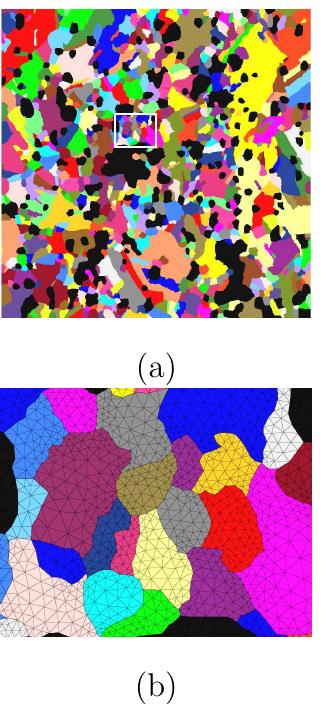
Fig. 10: (a) Dimensions of micro as well as macro structures and Fig. 9: Image (exported Figure 9. Image (exported from software Hypermesh) with “perfect” pixels from Figure 8b; ( b ) a meshing the transition zone in the two-scale simultaneous FE simulation; (b) cut-out corresponding to the white rectangle in ( a ) from software Hypermesh) the meshing of the whole structure in the two-scale simulation; (c) with “perfect” pixels for meshing in the square-shaped transition zone; (d) part of the meshing Fig. 8 (b); (b) a meshing in the transition zone and the geometrical adaptive meshing of the cut-out corresponding to real microstructure with 750 Ag grains and 222 SnO the white rectangle in (a) Fig. 8 (b)). [49].